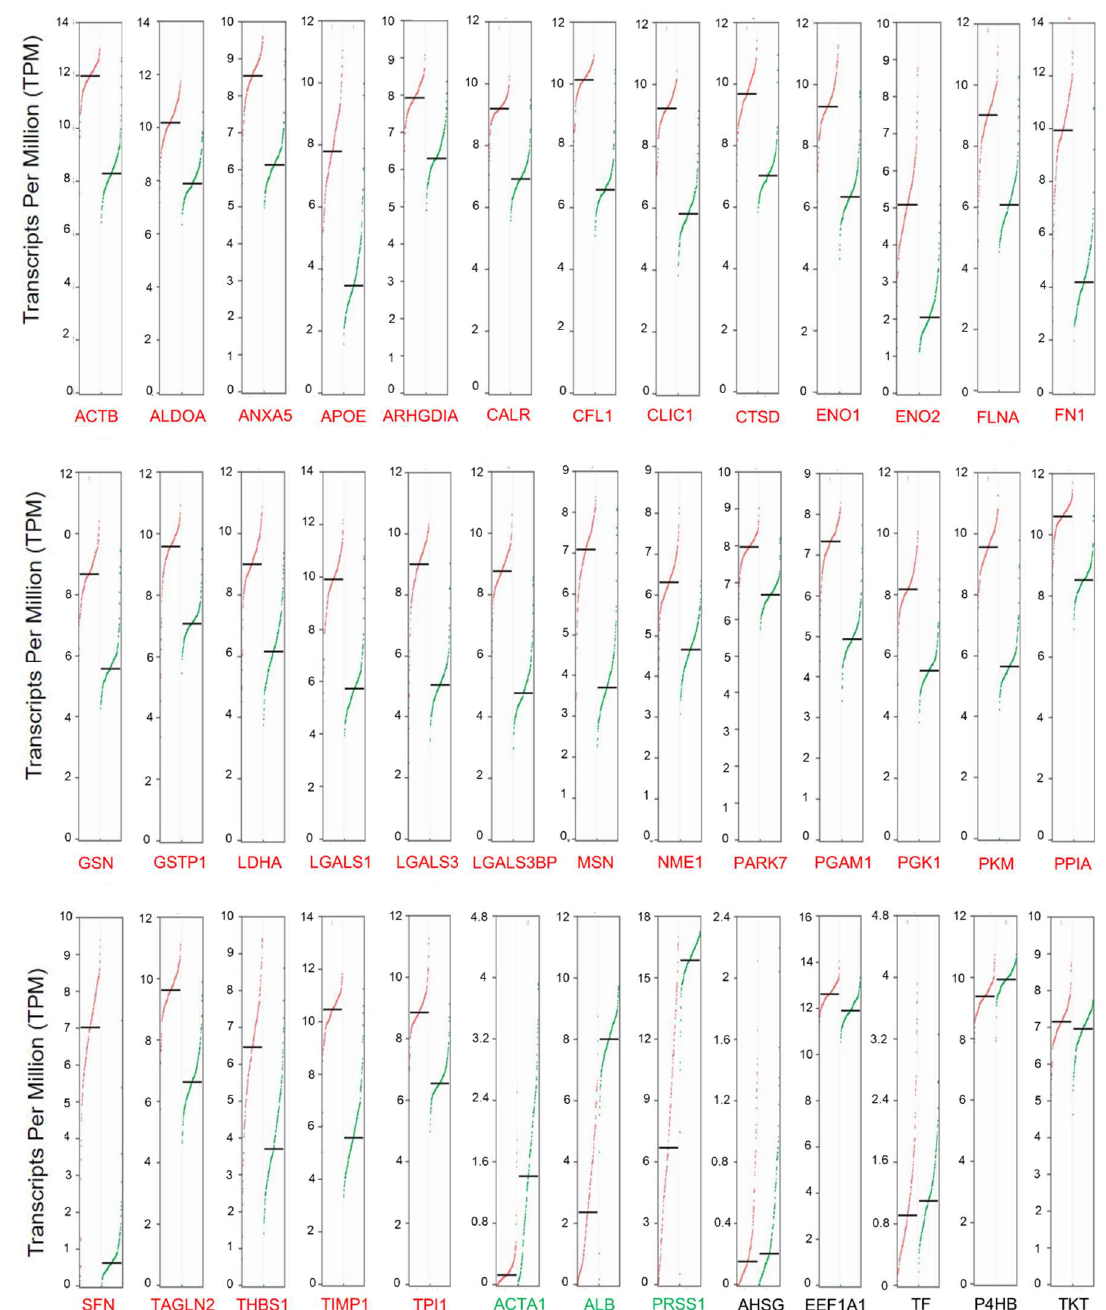
Figure 4. Di ff erential gene expression of transcripts translated into secreted proteins in pancreatic ductal adenocarcinoma. Di ff erential expression levels were calculated using the web-based Gene Expression Profiling Analysis tool (GEPIA) [102]. GEPIA analysis revealed that most of the 39 genes of the proteins identified as secreted are positively regulated in pancreatic ductal adenocarcinoma (PDAC). Genes were considered positively or negatively regulated (written in red and green, respectively) in PDAC ( n = 179) relative to normal tissue (TCGA, n = 4; GTEx, n = 167) when absolute values of fold-change were > 1.0 and the q -value < 0.01 (ANOVA). Red dots: pancreatic tumor samples; Green dots: normal pancreatic samples.